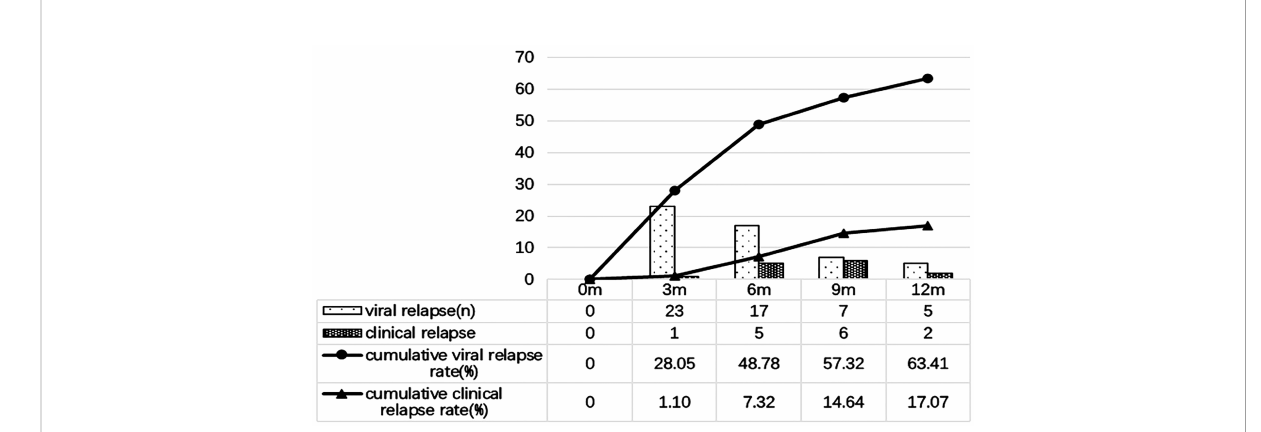
FIGURE 2 Viral relapse and clinical relapse in patients after stopping oral antiviral